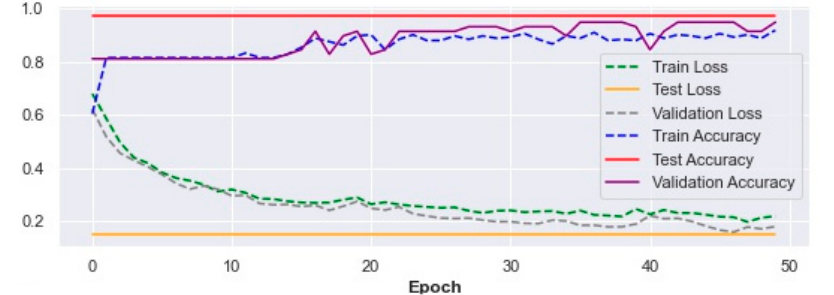
Figure 3. Train, test, and validation accuracy and loss results in the 4p-SAFE model.